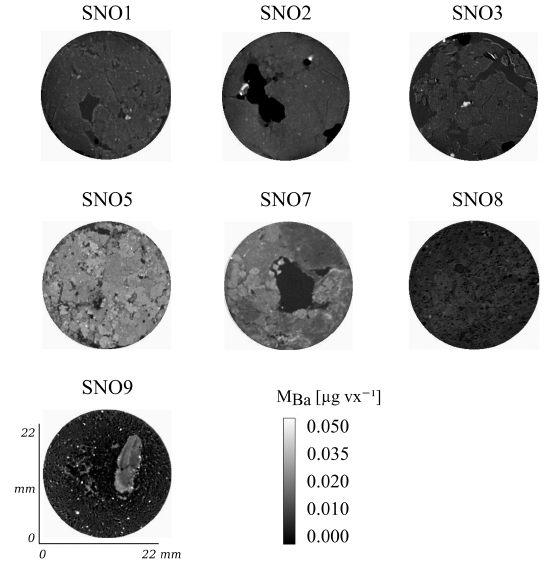
Figure 9. Difference images of the seven intact soil samples. The greyscale represents the Ba 2 + mass (M Ba ) in µg per voxel (vx). Depth from the soil surface: SNO1, SNO2 and SNO3 at 8mm; SNO5 at 15mm; SNO7 and SNO8 at 9mm; and SNO9 at 5mm.